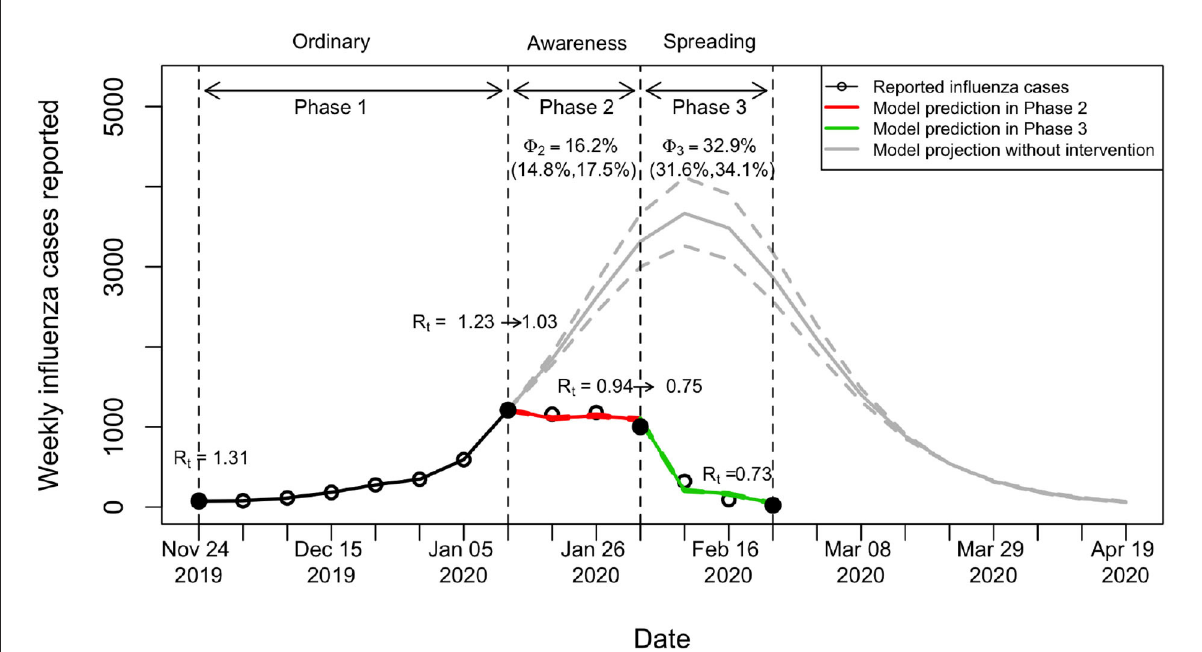
FIGURE2 Model prediction of influenza cases in 2019–20 winter influenza season in Hong Kong. R t at the boundaries (the second and third dashed lines) between phases were estimated from the model taking account of changes in both behavior and herd immunity. The prediction in Phase 2 (Awareness: the period immediately after people were aware of the existence of COVID-19) is shown in red. The prediction in Phase 3 (Spreading: the period immediately after local COVID-19 cases began to spread) is shown in green. The prediction intervals in Phase 2 and 3 are shown with narrow intervals. 8 denotes the percentage of reduction in R t at Phase 2 and 3 compared to Phase 1, resulting from the changes in behavior only (i.e., excluding the effects from herd